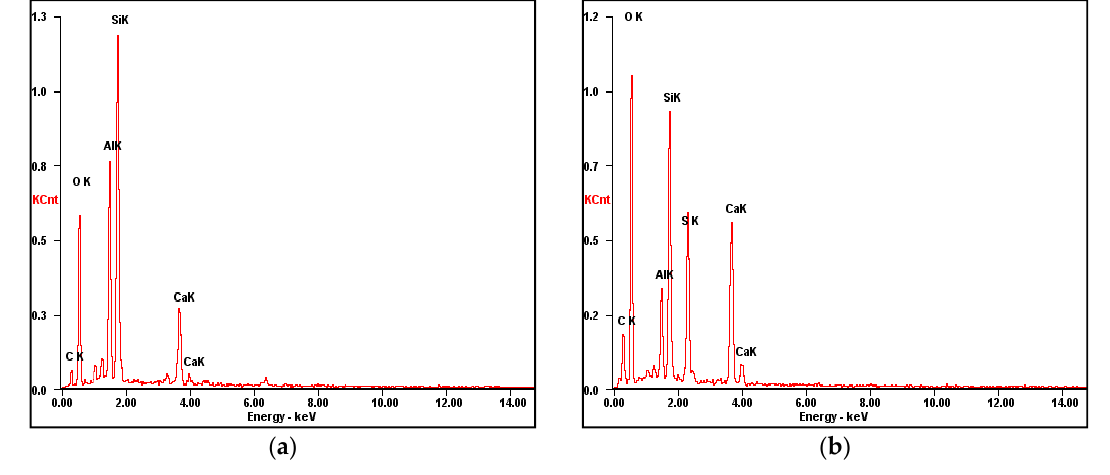
Figure 6. Energy spectrums of slurry from Figure 5a “1” ( a ) and Figure 5c “2” ( b ); ( a ) EDS from Figure 5a; ( b ) EDS from Figure 5c.